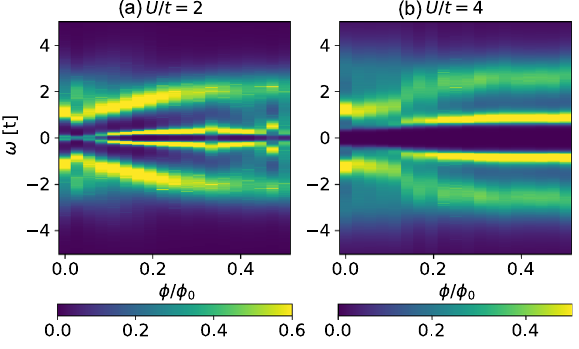
Fig. 5 Density of states at half- fi lling. The density of states at half- fi lling ( 〈 n 〉 = 2) and β = 30/ t for ( a ) U / t = 2 and ( b ) U / t =